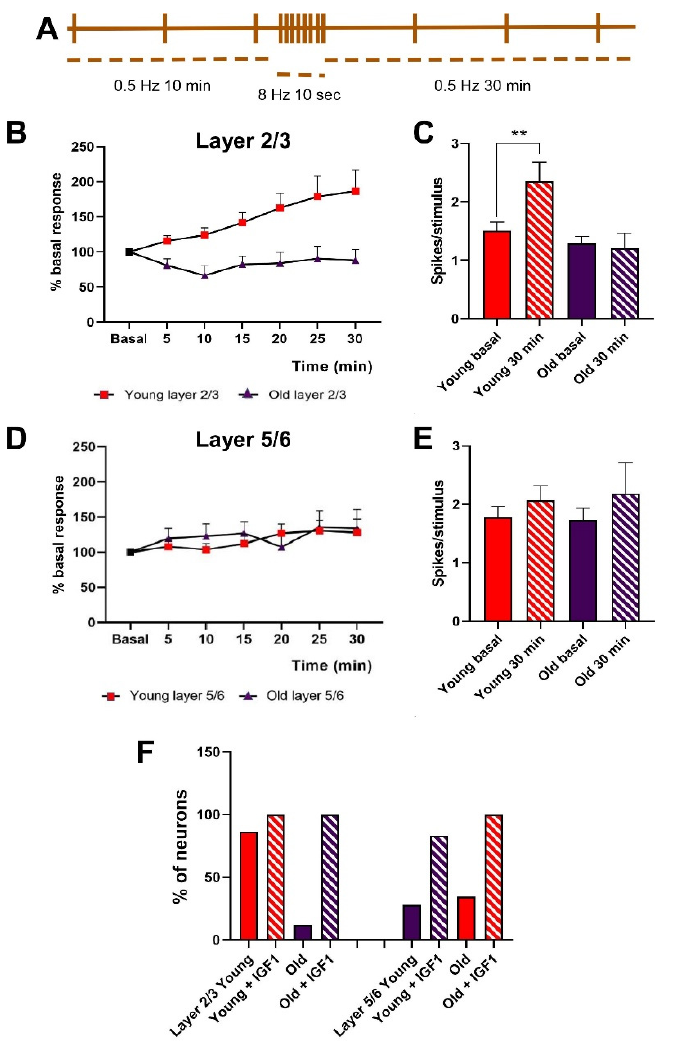
Figure 2. Response facilitation in young and old mice after a stimulation train in the whiskers. ( A ) Stimulation protocol scheme of whiskers to test long-lasting response facilitation. ( B ) Time course recorded in layer 2/3 neurons in young (red boxes) and old (purple boxes) animals. The young animals showed a significant increase in their mean response after the stimulation train (8 Hz; 10 s). The time course was statistically significant compared with old animals that did not increase their response after the stimulation train (two-way ANOVA F (1,280) = 27.34 p < 0.001). ( C ) Mean responses (spike/stimulus) are shown in baseline conditions and at 30 min after the stimulation train in layer 2/3 neurons (**, p < 0.01). Note that only neurons from young animals were facilitated by the stimulation train. ( D , E ) Neurons in layer 5/6 did not show a significant increase in their response after the stimulation train in neither young nor old animals. There were also no differences between the two animal groups (two-way ANOVA F (1,161) = 0.42 p = 0.51). A Student’s t-test was used in ( C , E , F ) The percentage of neurons that showed a facilitation was higher in young animals than in old ones in layer 2/3 of the somatosensory cortex. However, it was similar in layer 5/6 of both groups. The percentage of neurons that showed response facilitation increased in the presence of IGF-I.